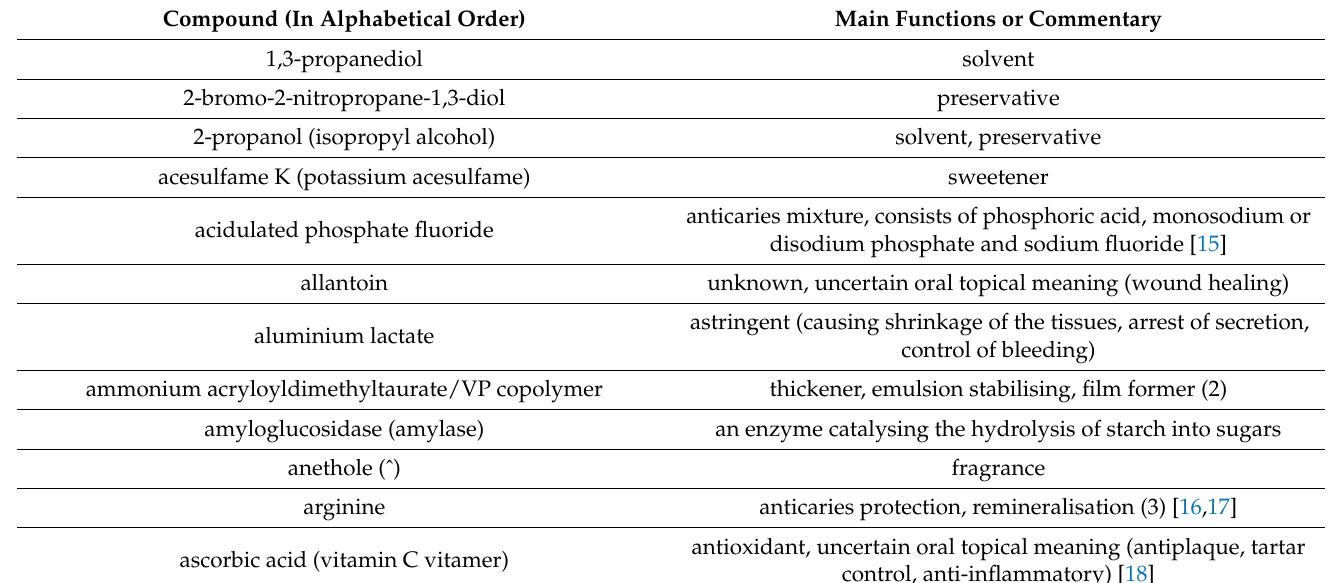
Table 1. Ingredients of mouthwashes and their main functions